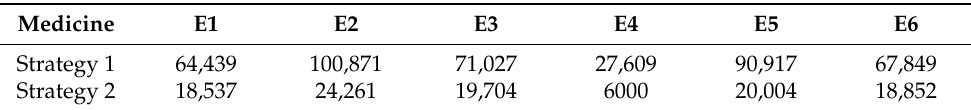
Table 5. Number of sentences for each error type for the medicine datasets. Error types: genre (E1), number (E2), genre-number (E3), homophone (E4), Hunspell-generated (E5) and subject-verb concordance